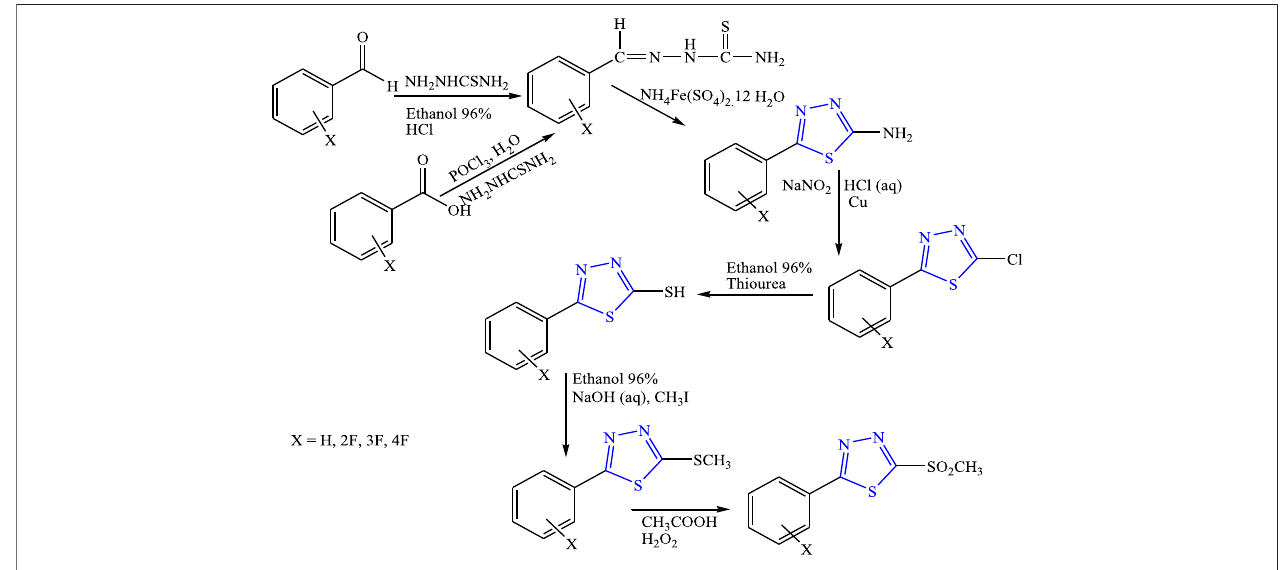
FIGURE 31 | Synthetic pathway for synthesizing new 5-aryl-1,3,4-thiadiazole derivatives.